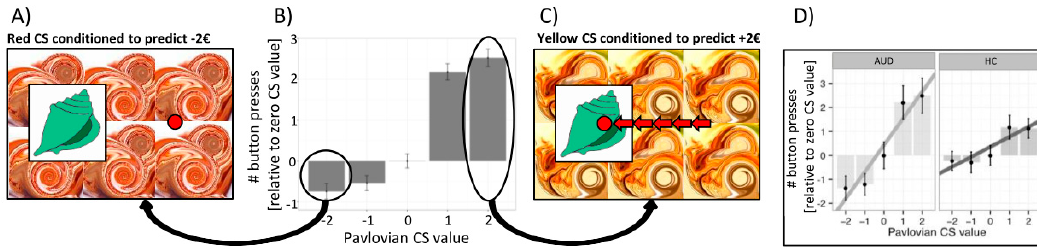
Figure 1. The Pavlovian-to-instrumental (PIT) effect. ( A ) The unrelated Pavlovian stimulus (conditioned stimulus (CS)) presented in the background is negatively valued because it has previously been paired with passive monetary loss. ( B ) The PIT effect is indicated by the number of button presses (instrumental response) as a function of the value of the respective Pavlovian background stimulus ( − €2, − €1, €0, +€1, +€2). ( C ) Combining the shell with a positive Pavlovian cue in the background of the screen increases approach behavior (number of button presses) in the unrelated instrumental task. ( D ) The PIT effect was significantly stronger in subjects with alcohol use disorder (AUD) compared to healthy controls (HC).